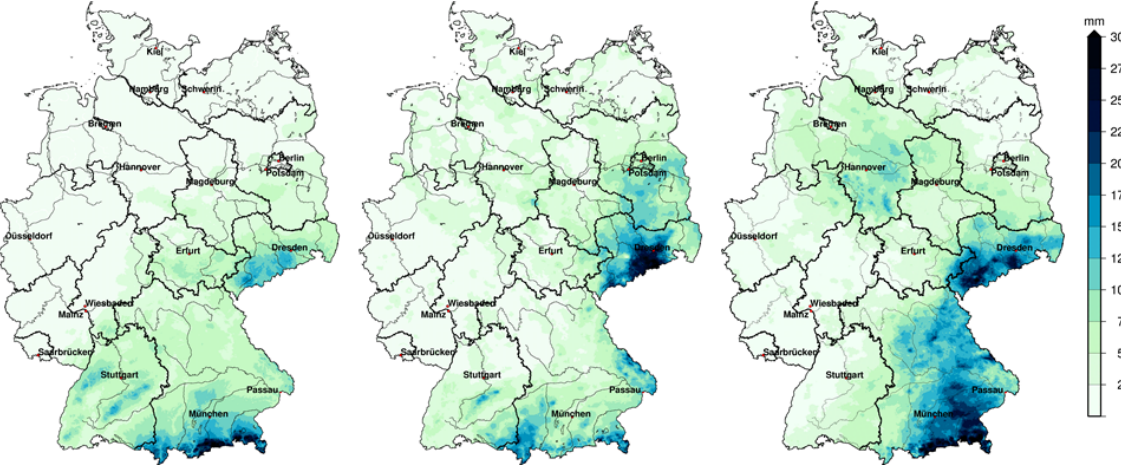
Figure 4. The 3-day maximum precipitation according to REGNIE data sets for June 2013 (left), August 2002 (middle) and July 1954 (right).